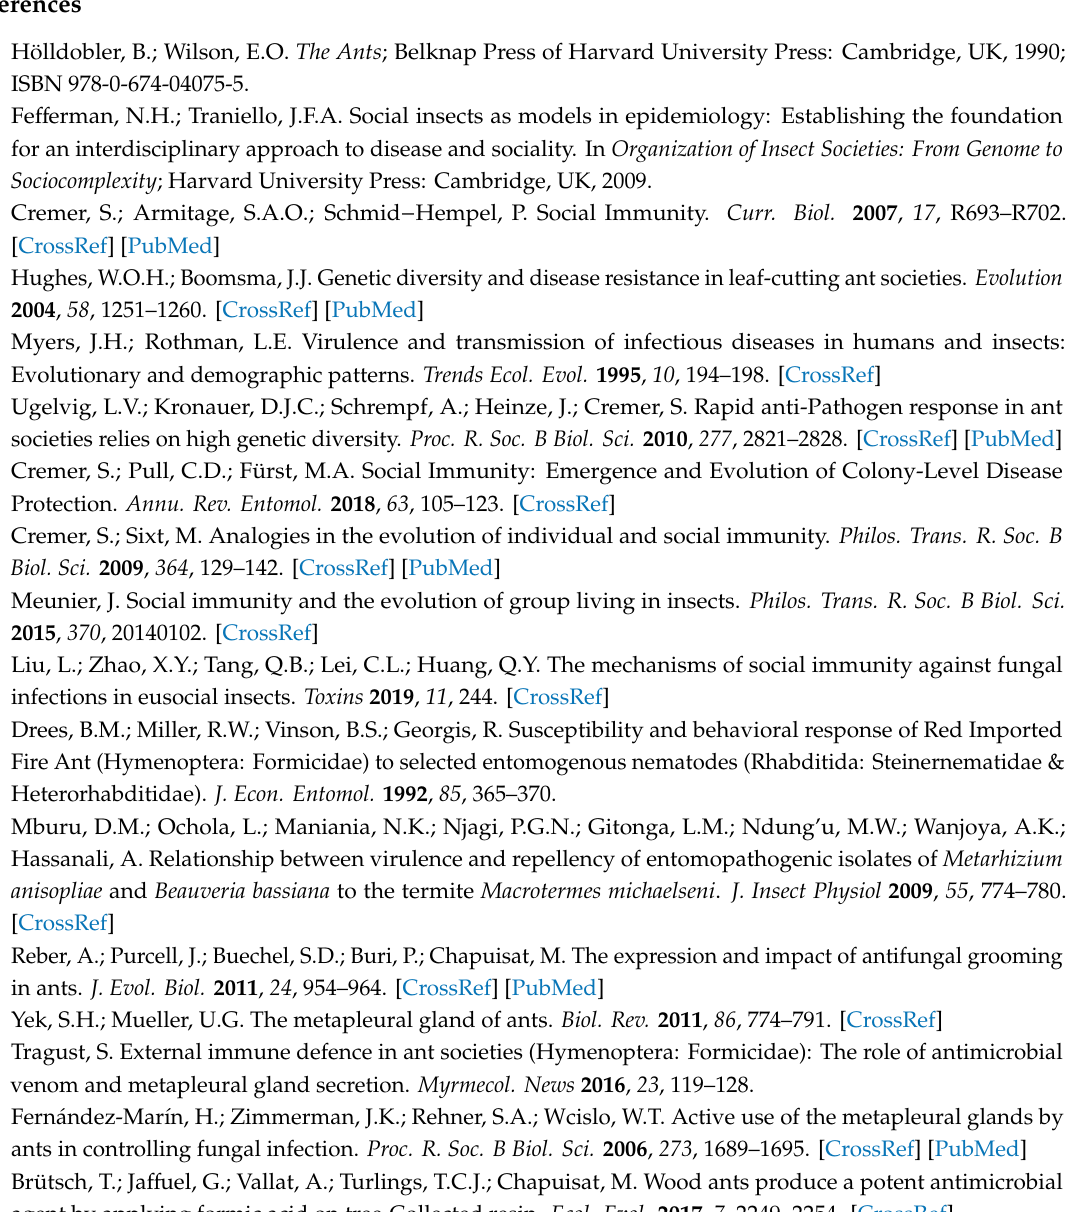
Table S1: Mean number of allogrooming events per recording of 30 ants; Table S2: Mean number of trophallaxis events per recording of 30